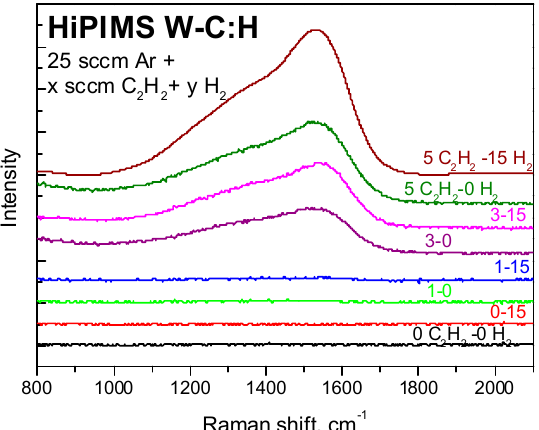
Figure 3. Qualitative comparison of Raman spectra in the studied HiPIMS W-C:H coatings in dependence on the amount of acetylene and hydrogen additions into Ar sputtering atmosphere during hybrid PVD–PECVD process. The shortened abbreviation at the individual coatings corresponds to the flows of C 2 H 2 and H 2 in the sputtering atmosphere during deposition.